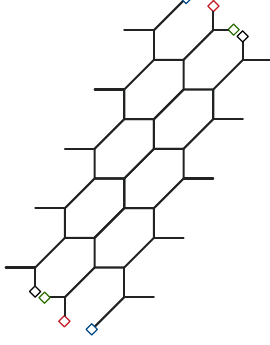
SU(4) 0 SU(4) 0 [6]. (cid:0) (cid:0) (cid:0)